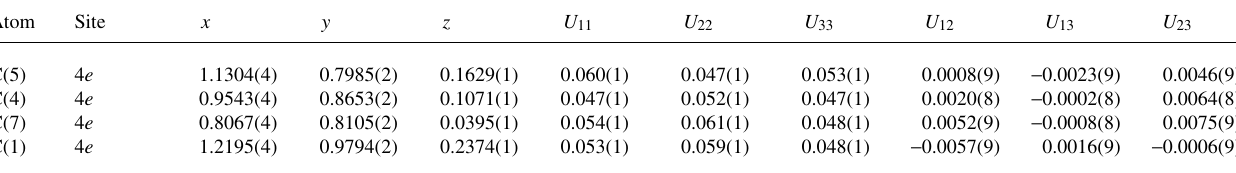
Table 3. Atomic coordinates and displacement parameters (in Å 2 )